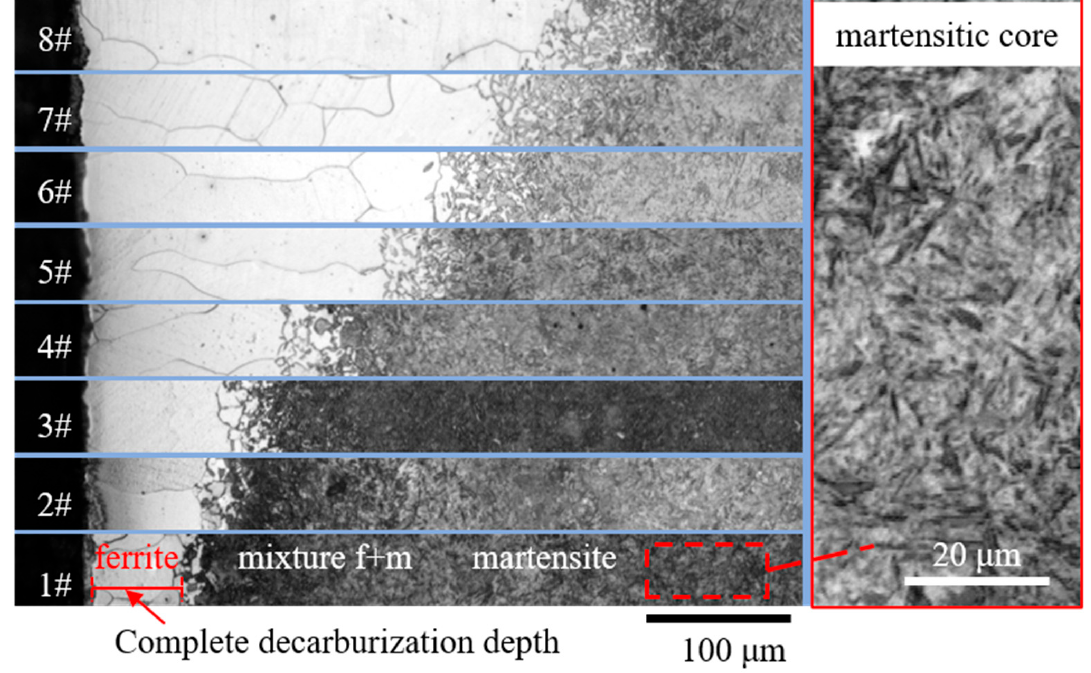
Figure 2. Metallographic pictures of the cross-sections of steel samples with martensitic core austenitized for 0.5 h (Sample 1#), 1 h (Sample 2#), 1.5 h (Sample 3#), 2 h (Sample 4#), 3 h (Sample 5#), 4 h (Sample 6#), 5 h (Sample 7#), and 6 h (Sample 8#). The needle-like microstructure can be observed in the martensitic core.